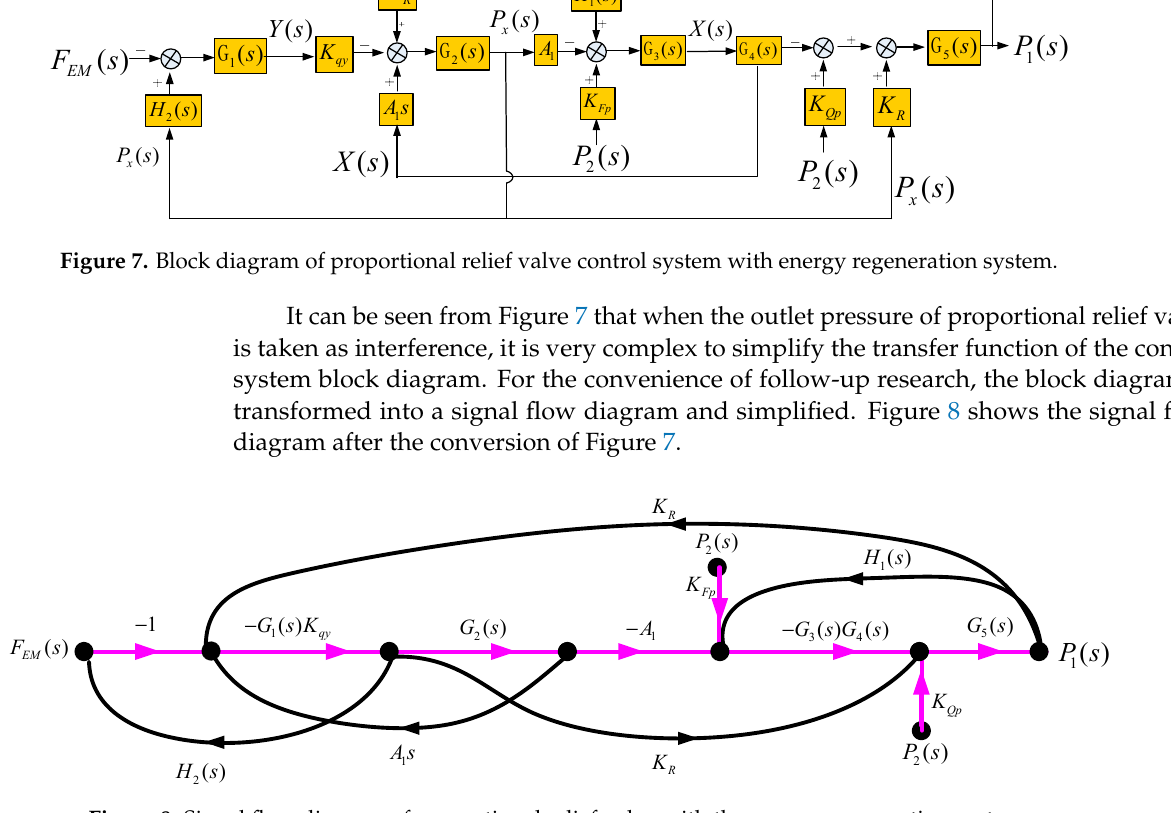
cuits are the same.